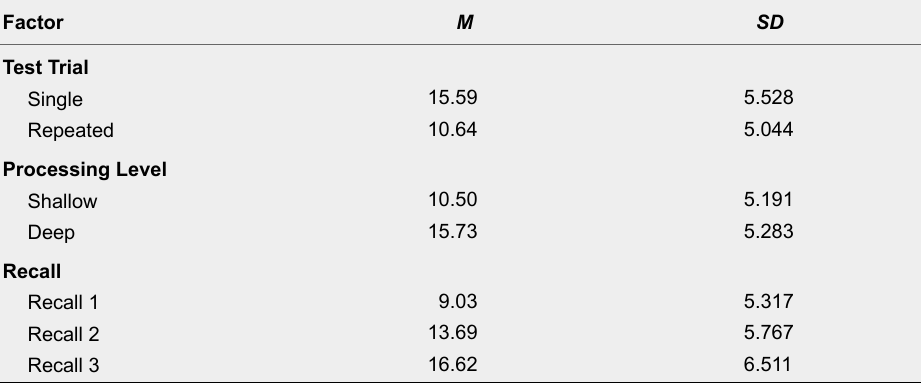
Means and Standard Deviations of the Number of Words (Total = 40) Recalled in Test Trial by Processing Level in the Learning Phase (N = 76) Factor M SD Test